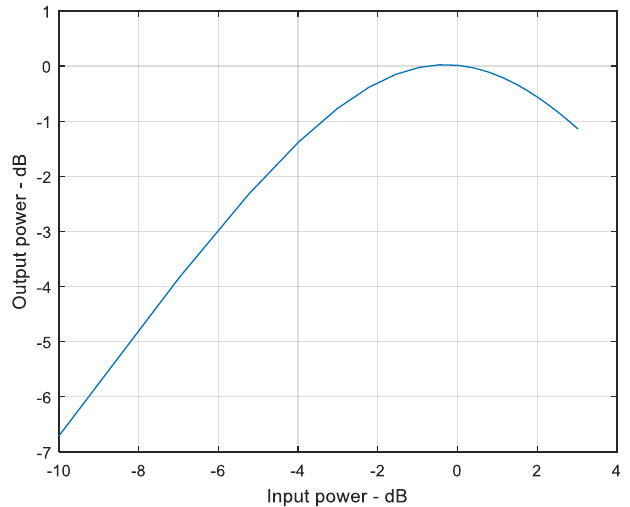
Figure 4. AM/AM characteristic curve of the Saleh model.